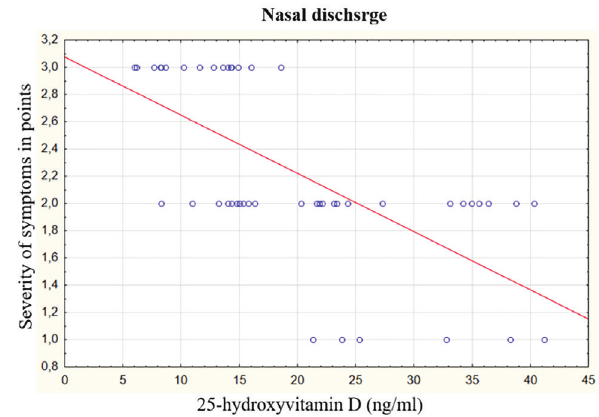
Figure 3 - Prevalence of vitamin D deficiency among different age categories